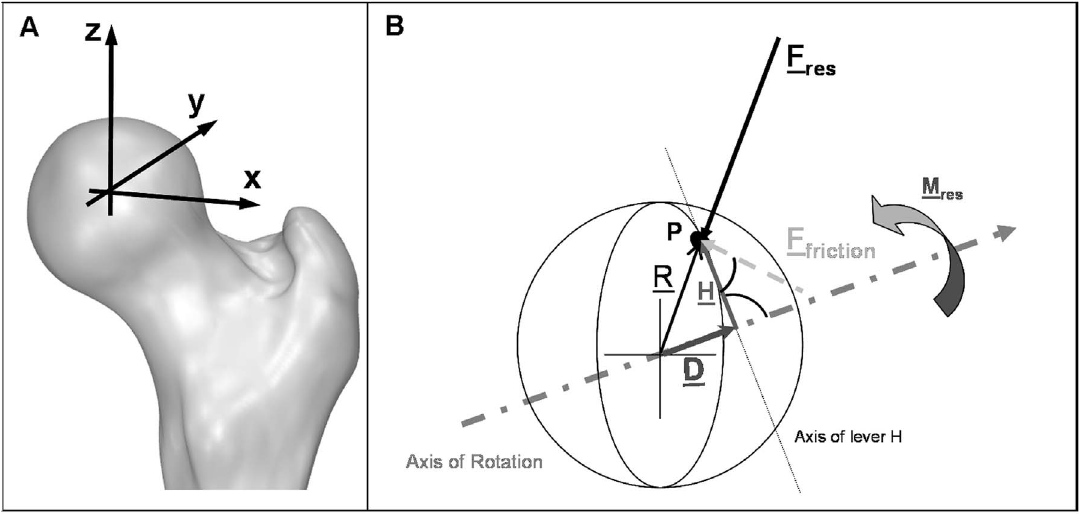
Figure 1. Coordinate system and vectors for calculation of the coefficient of friction m . Right joint, posterior view. doi:10.1371/journal.pone.0078373.g001 PLOS ONE |